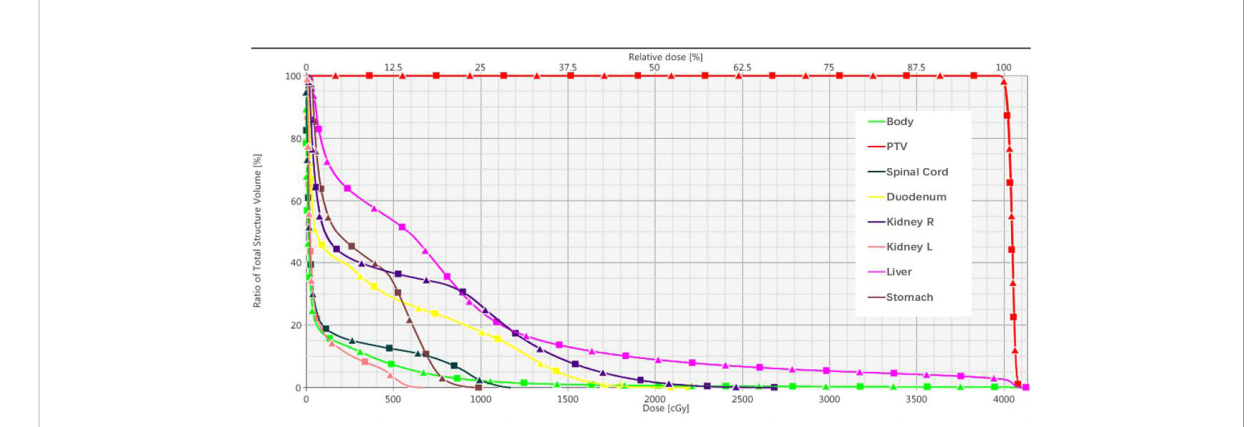
FIGURE 7 Dose-volume histograms of corresponding VMAT plan in Case 2. (Square solid line: TB-10MV; Triangle solid line: E syn -10MV).